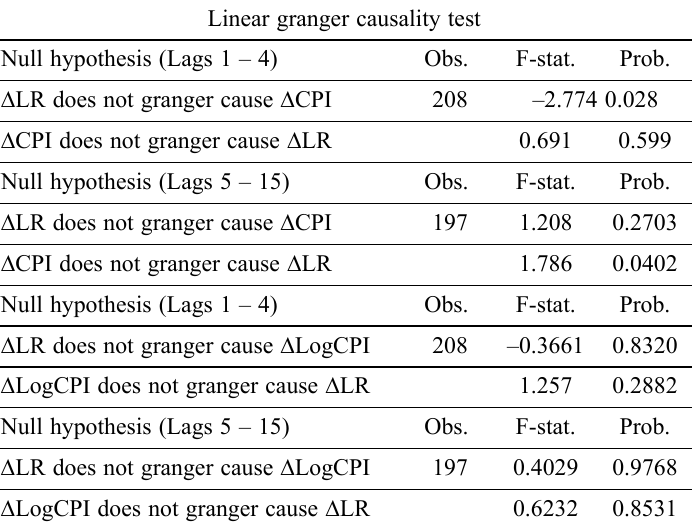
Table 7. Linear granger causality test (first